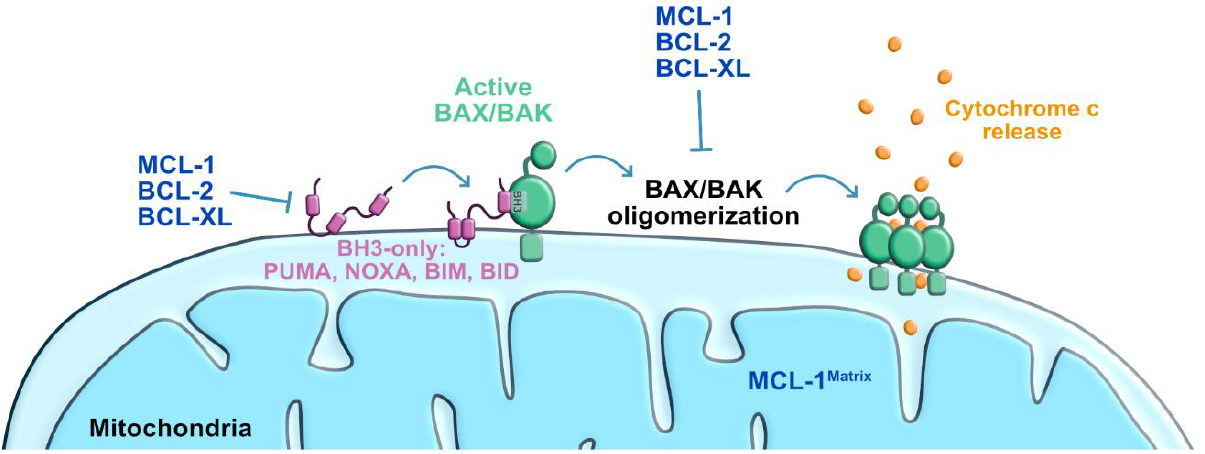
FIGURE 2: Scheme of the mitochondrial pathway of apoptosis. Stress-induced activation of BAX/BAK leading to mitochondrial outer mem- brane permeabilization and cytochrome c release to the cytosol. Anti-apoptotic proteins block BAK/BAX activation/oligomerization induced by BH3-only proteins. BCL-XL: B-cell lymphoma extra-large; MCL-1: myeloid cell leukemia 1; BID: BH3-interacting domain death agonist; BIM: BCL-2 interacting mediator of cell death; PUMA: P53-upregulated modulator of